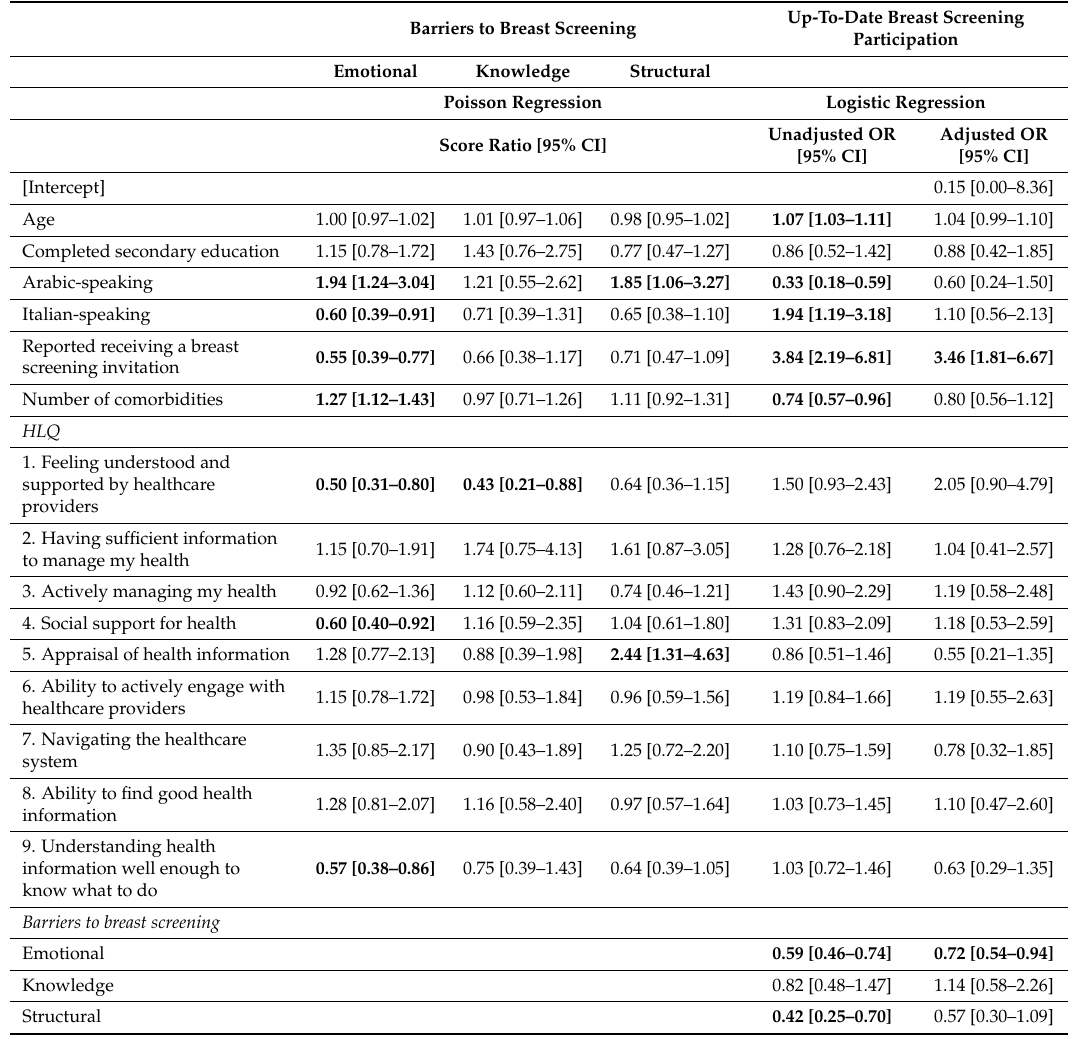
Table 5. Association between health literacy, barriers to breast screening and being up-to-date with breast screening